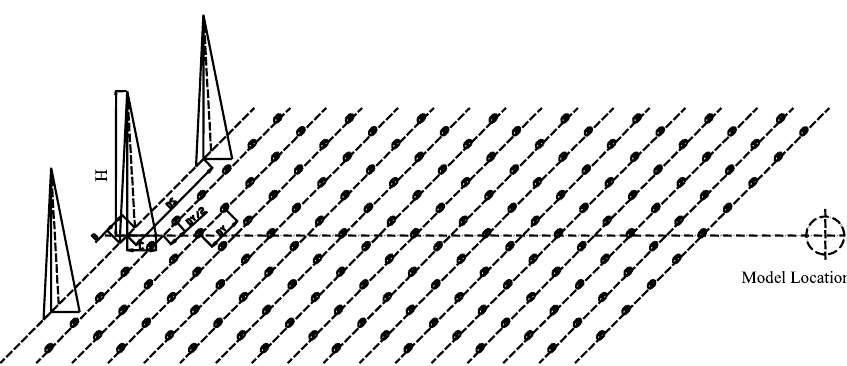
Fig. 1 Map of layout of the triangle wedges and roughness elements in the wind